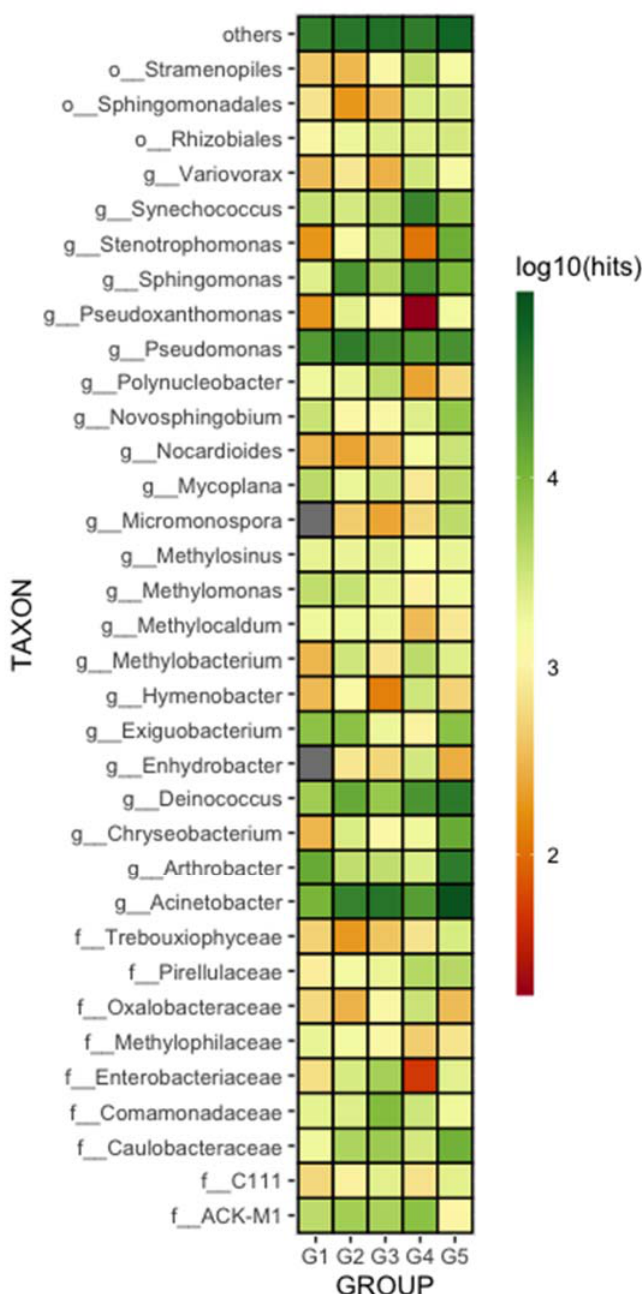
Figure 4. Heatmap of relative abundance of bacterial taxa DNA in water samples according to geographic proximity. Species composition percentages are displayed as the normalized proportion of the microorganism specific counts observed in each sample relative to the total microbial species diversity of the sample (0.5% cut-off). Color gradient key displays the scale of relative abundance in log scale.